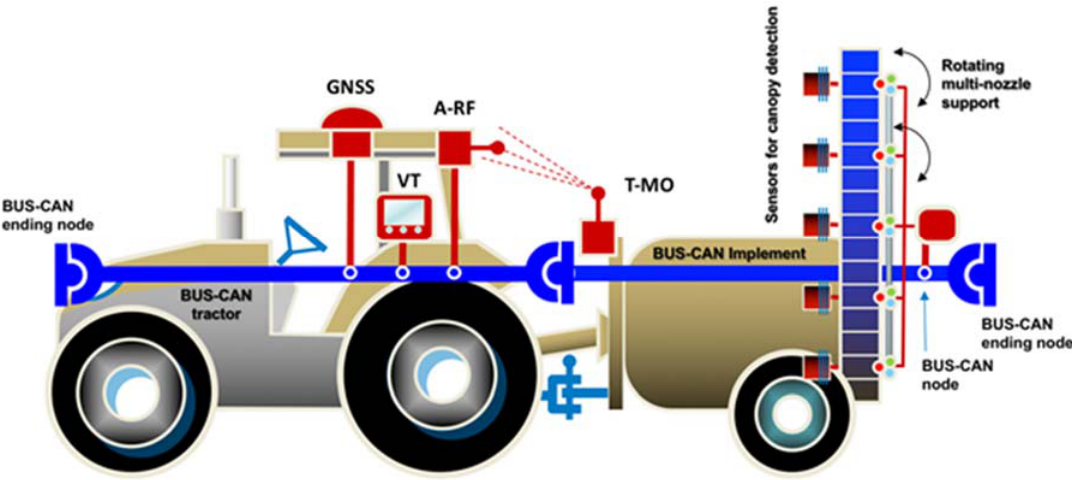
Figure 5. Design of a possible retrofit device to be applied to sprayers already present at the vineyard to enable them to operate according to site-specific logics. The retrofit application concerns a vertical spraying tower equipped with a set of rotating supports for independent nozzle selection and activation. The control is supported by a set of volumetric ultrasonic sensors able to detect the size of the canopy to be processed. The solution even includes a Field Operation Register Keeping (FORK) system based on an identification device enabling the tractor to automatically detect the identity of the coupled machine through a simple Radio Frequency (RF) system (T-MO: implement transmitting code; A-RF: tractor receiving antenna; identification is enabled only on distances <20 m). On board data transmission is performed via Controller Area Network (BUS-CAN), supposing this is already available on-board. In case of older tractors (no BUS-CAN), a direct wire connection can be easily